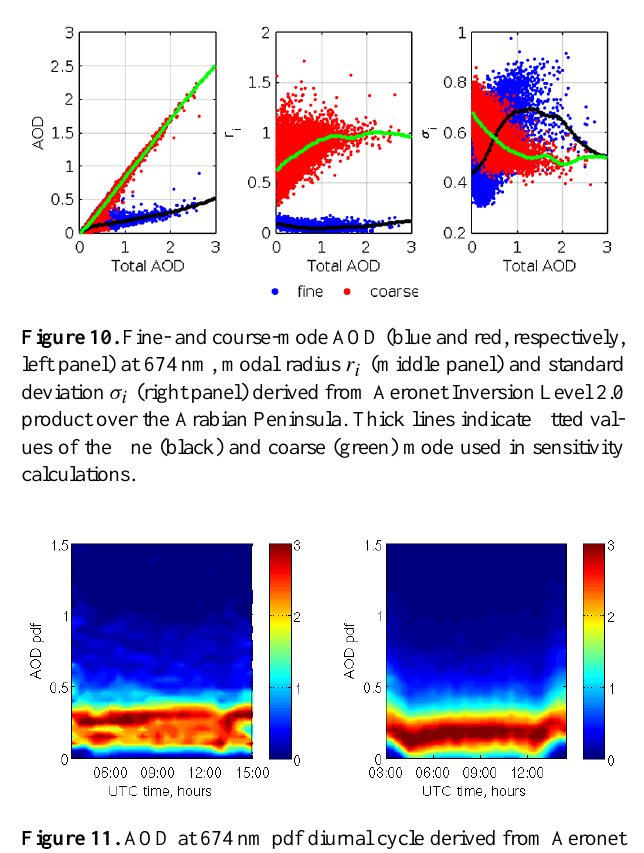
Figure 11. AOD at 674nm pdf diurnal cycle derived from Aeronet AOT level 2.0 product at KAUST (left panel) and Solar Village (right panel). Data span is 2012–2014 at KAUST and 1999–2013 at Solar Village. Both locations are in the + 3h time